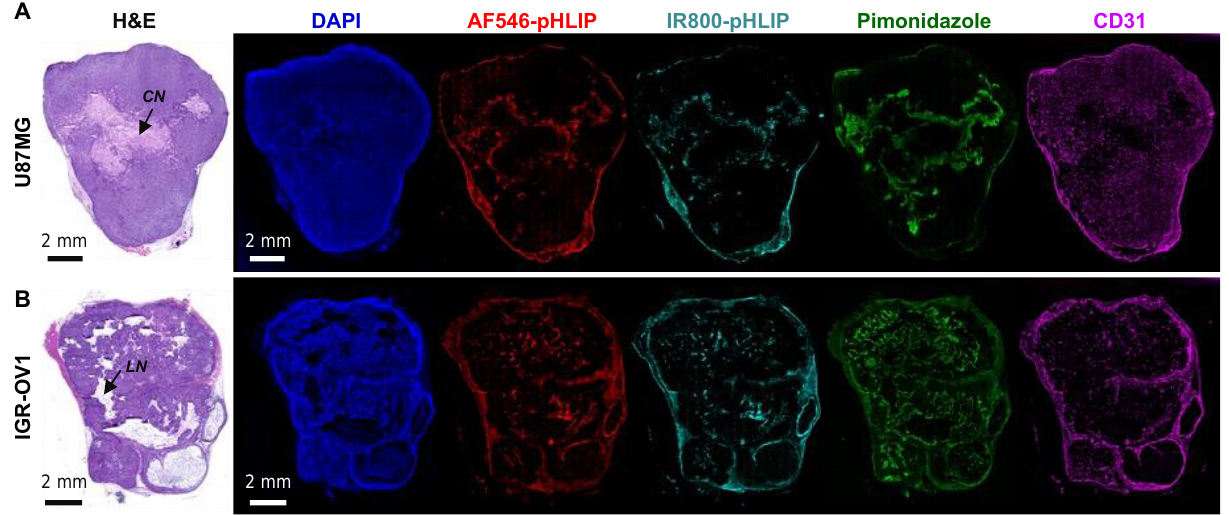
Figure 2. Distribution of pHLIP on whole-tumor sections. U87MG ( A ) or IGR-OV1 ( B ) tumor-bearing mice were intravenously injected with a cocktail of AF546-pHLIP and IR800-pHLIP (5 nmol each) and examined at 4 h post-injection. The images of pHLIP distribution (AF546-pHLIP, red; IR800-pHLIP, aqua) are displayed in parallel with those of histologic sections stained with hematoxylin and eosin (H&E), pimonidazole-stained hypoxia (green), CD31-stained microvessels (magenta), and DAPI-stained nuclei (blue). All fluorescence images were acquired on the same whole sections; H&E staining was performed on adjacent sections. CN , representing a region of coagulative necrosis; LN , representing a region of liquefactive necrosis (cavity-like).